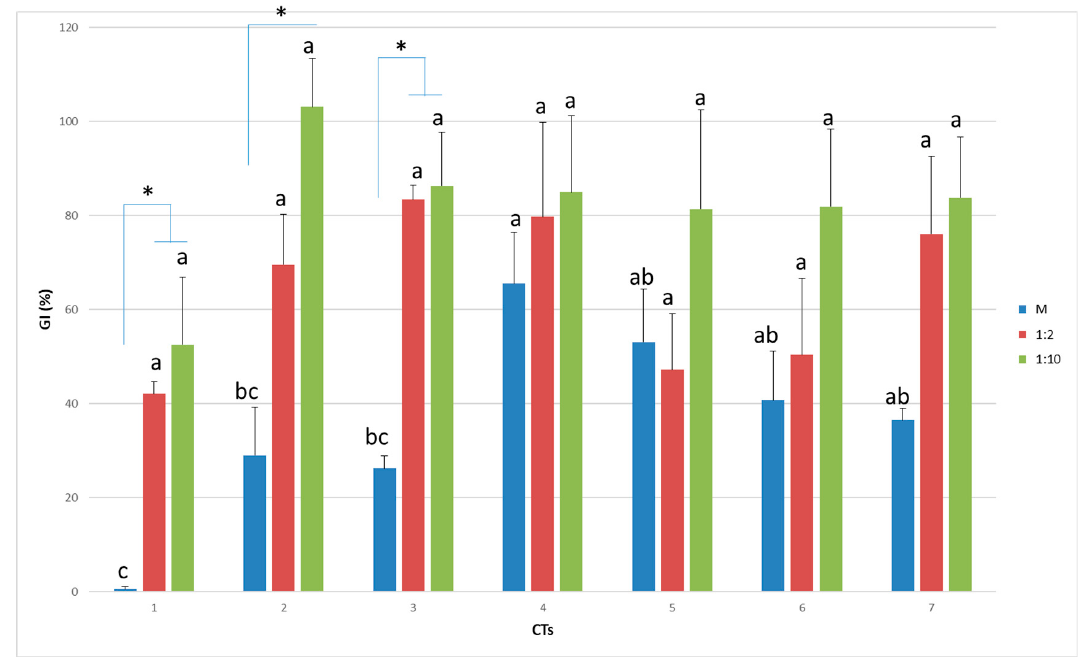
Figure 1. Germination index percentage (GI%) of Lepidium sativum L. seedlings treated with CTs (1–7) produced on-farm from composts listed in Table 1, not diluted (nd) and diluted (1:2 and 1:10). Bars indicate mean ± SE. Different letters on the bars indicate significant differences among CTs in the same dilution and asterisks indicate significant differences among dilutions in the same CT, according Tukey’s HSD test at p ≤ 0.05.